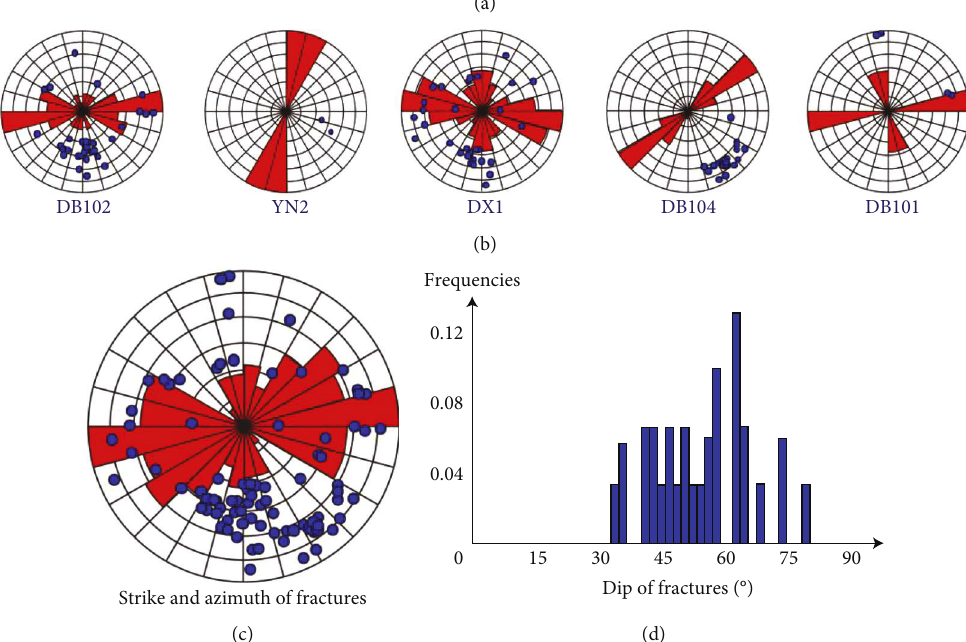
and fracture strike of the Dibei gas H